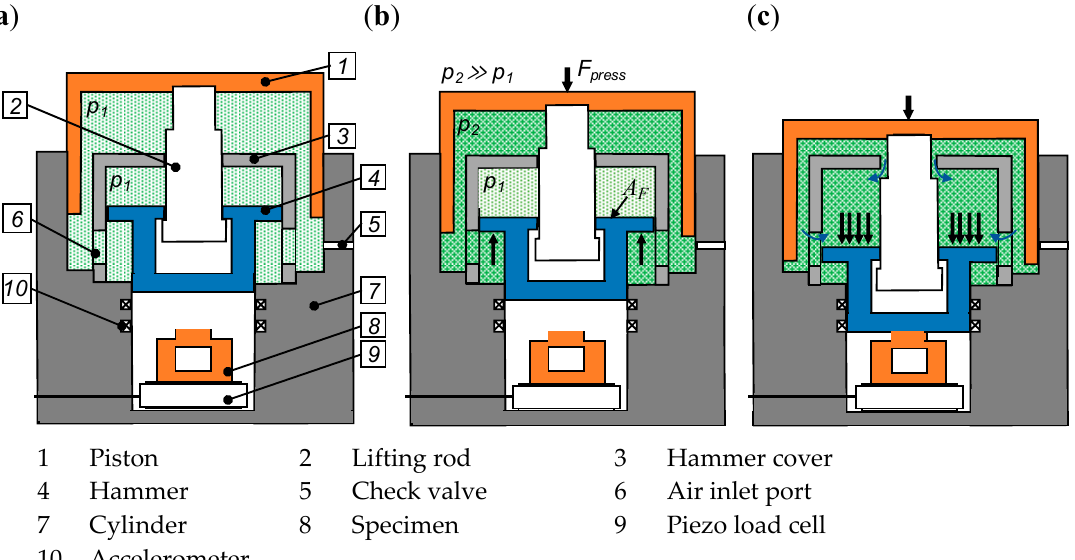
Figure 3. Principle of the pneumatically driven acceleration unit according to [48]: ( a ) neutral position, ( b ) pressurization, ( c ) impact.